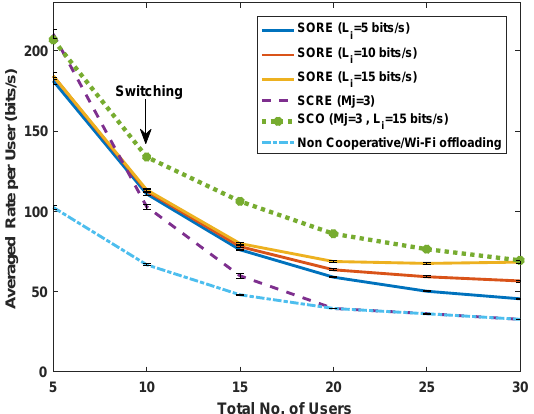
Figure 5. Averaged Achievable data rates per user by changing No. of Total UEs in Cooperative Communication, Without Cooperative Communication and by taking 5, 10, 15 leftover capacity in Wi-Fi offloading and overall 3